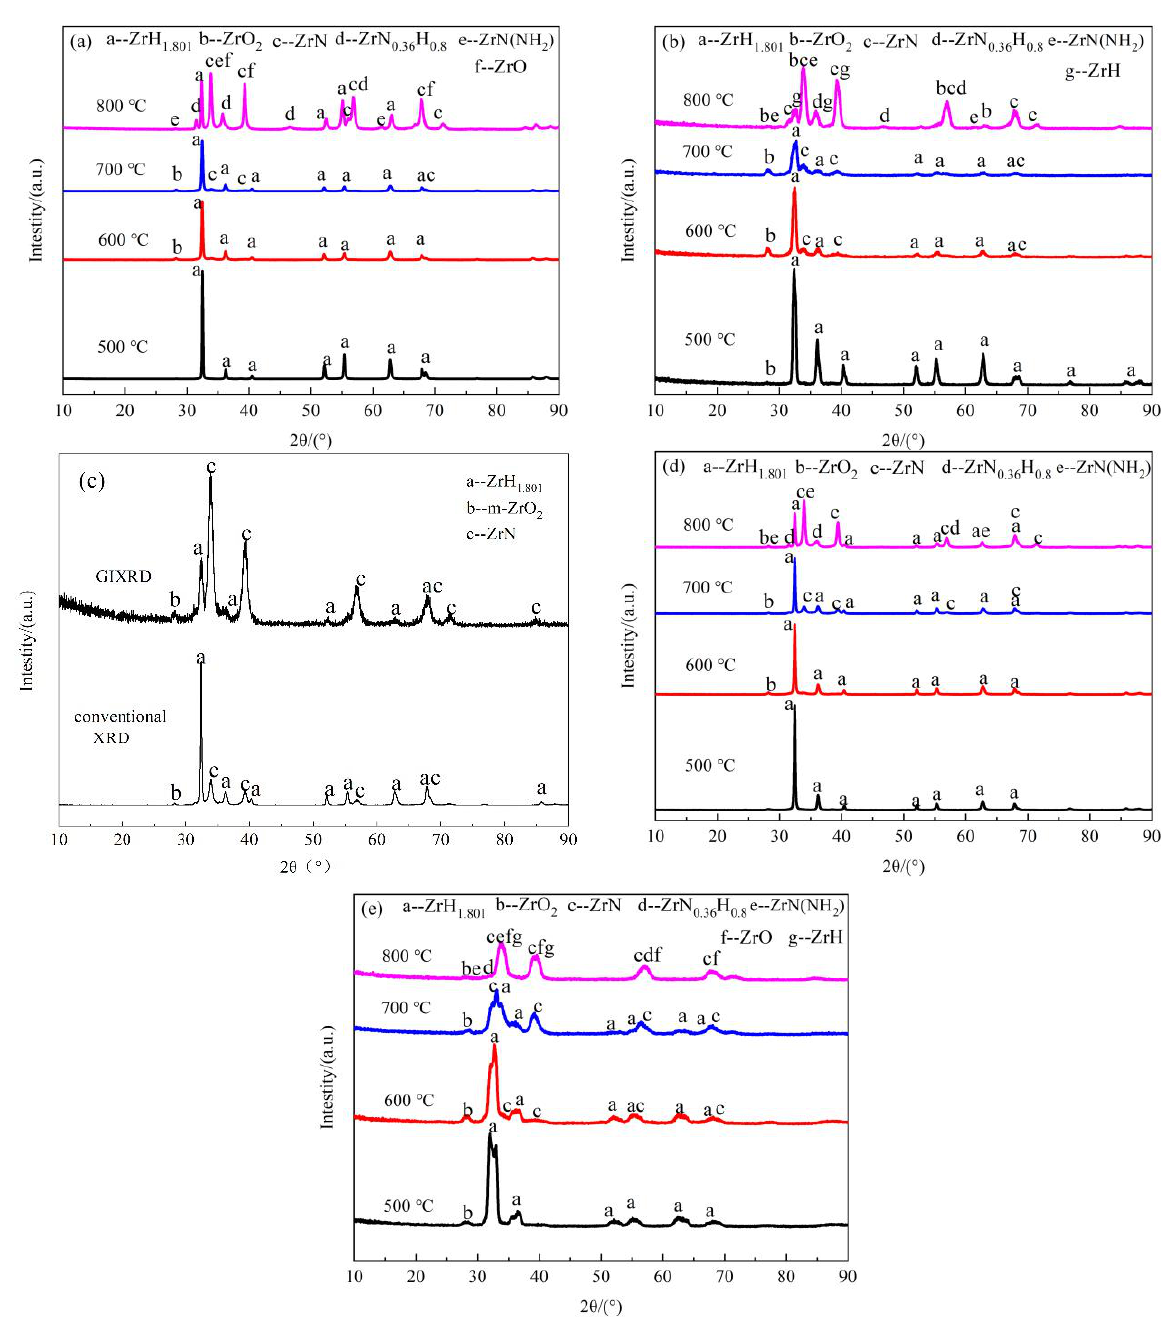
Figure 7. XRD spectra of zirconium hydride with nitride film prepared in different conditions ( a ) N 2 , 500~800 °C, 20 h, conventional XRD; ( b ) N 2 , 500~800 °C, 20 h, GIXRD; ( c ) N 2 , 800 ℃ , 5 h; ( d ) N 2 + H 2 , 500~800 °C, 20 h, conventional XRD; ( e ) N 2 + H 2 , 500~800 °C, 20 h, GIXRD. Table 4. The phase of zirconium hydride with nitride film prepared in different conditions.